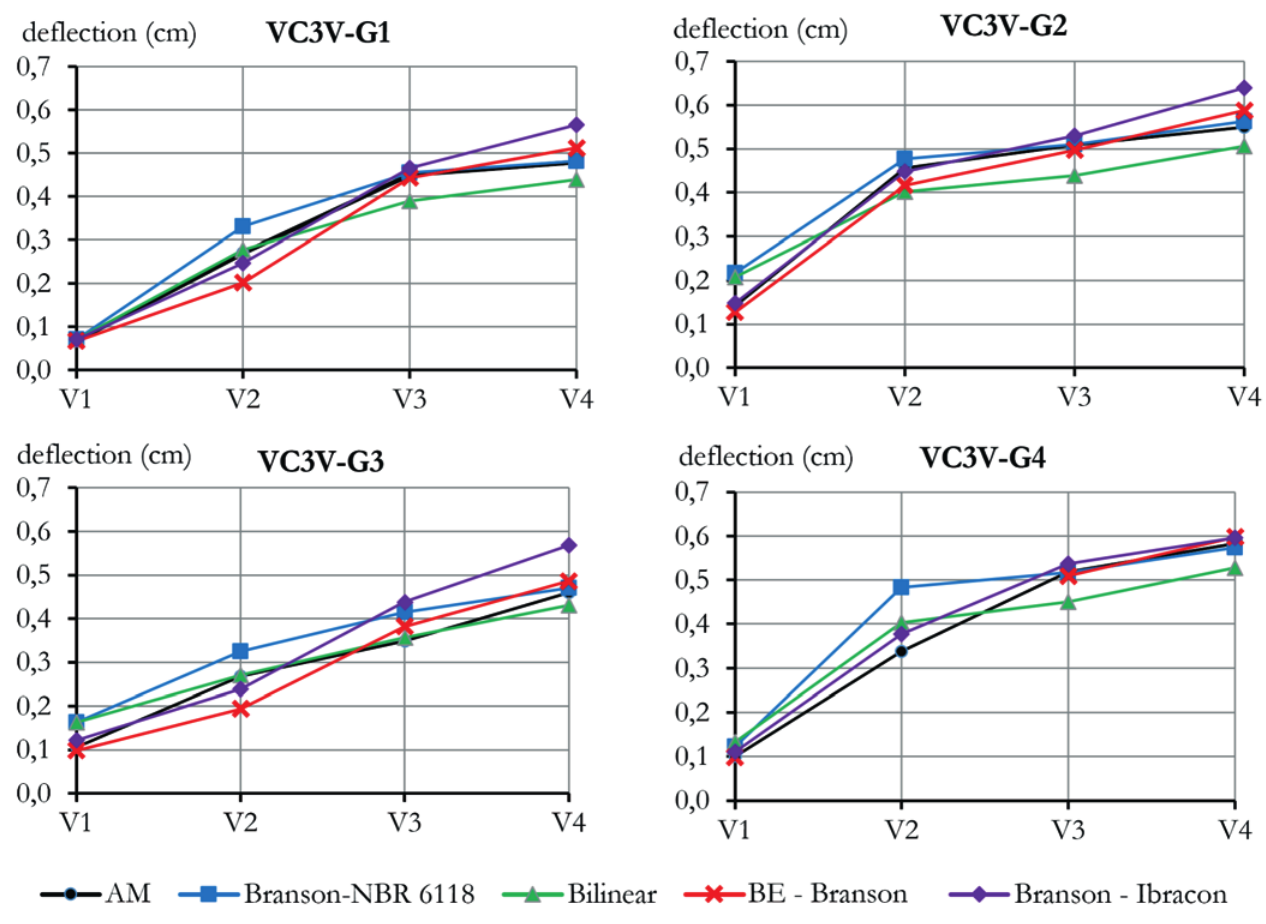
Maximum deflection values obtained by the different models/methods for the three-span